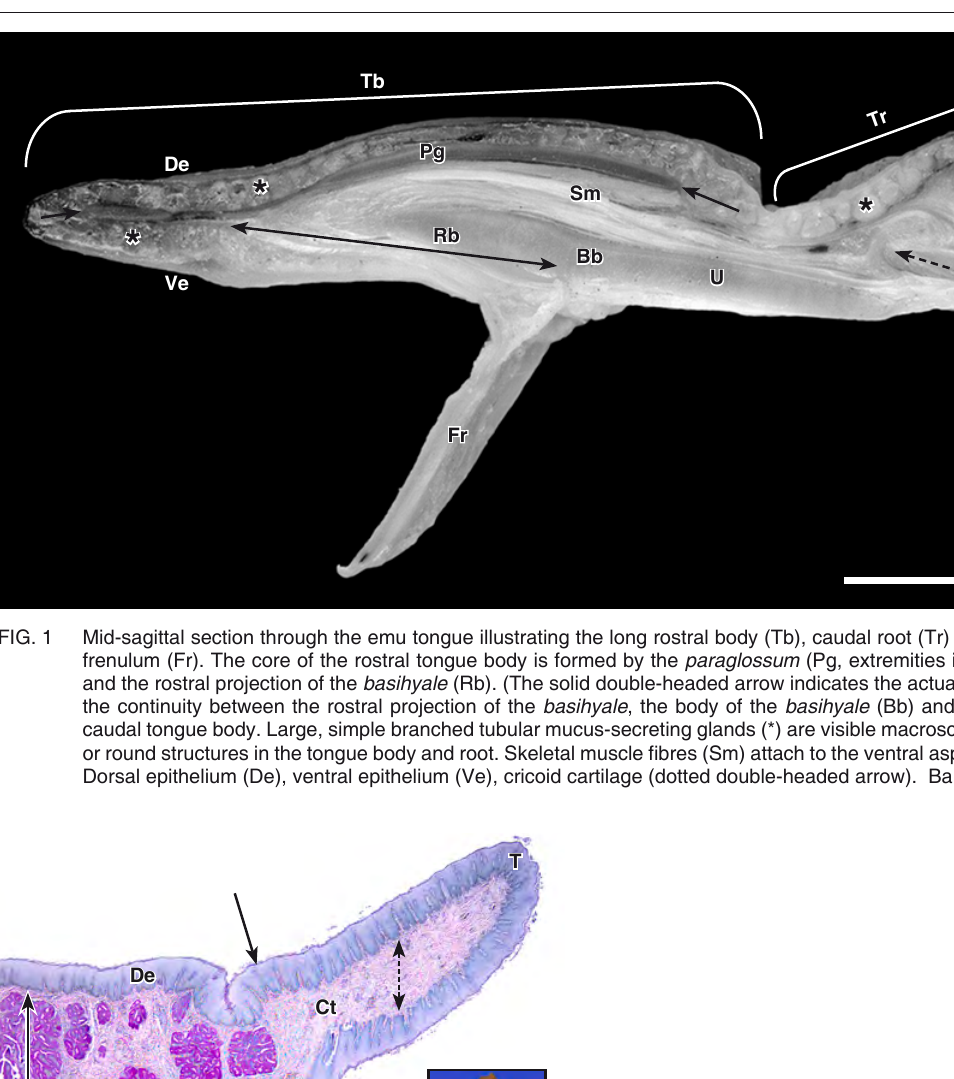
FIG. 2 Lateral lingual papilla in longitudinal section with the glandular tissue showing a positive PAS reaction. Note the abrupt termination (arrows) of the glands (Gl) leav­ ing only connective tissue (Ct) filling the space between the dorsal (De) and ventral epithelium (Ve). The thin­ ning of the connective tissue layer from medial (solid double­headed arrow) to lateral (dotted double­headed arrow) is also apparent. Papilla tip